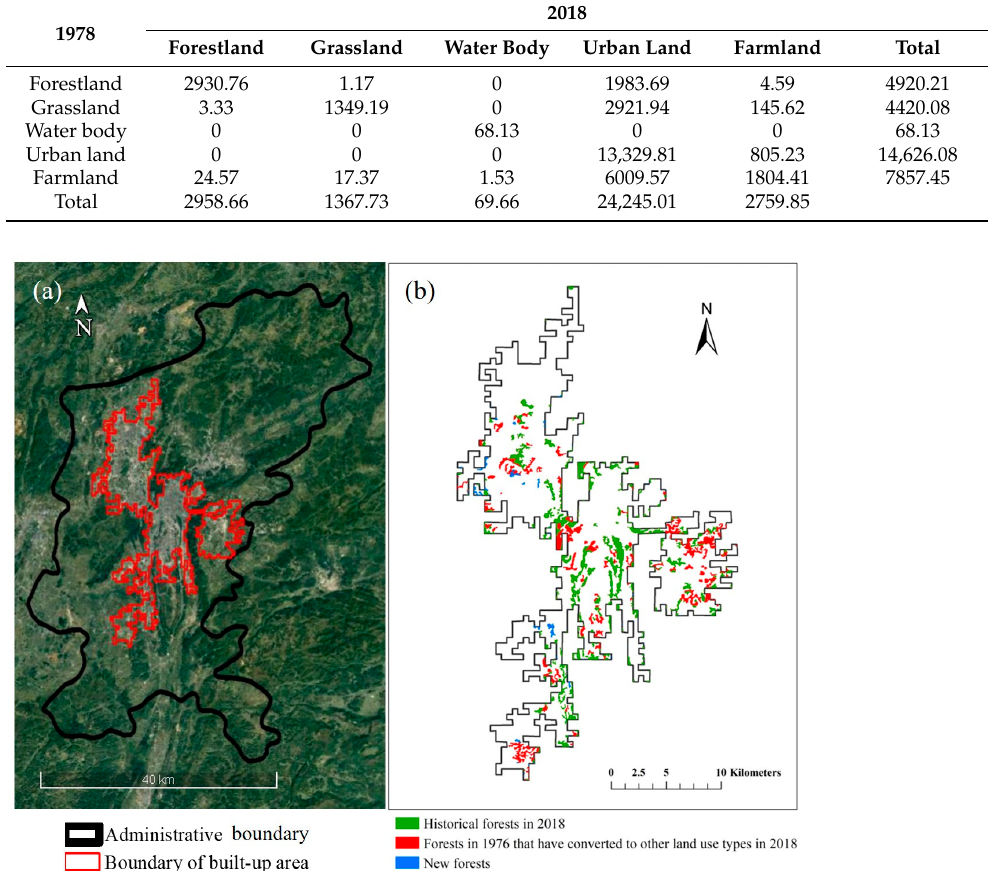
Figure 6. The number of historical forest patches.